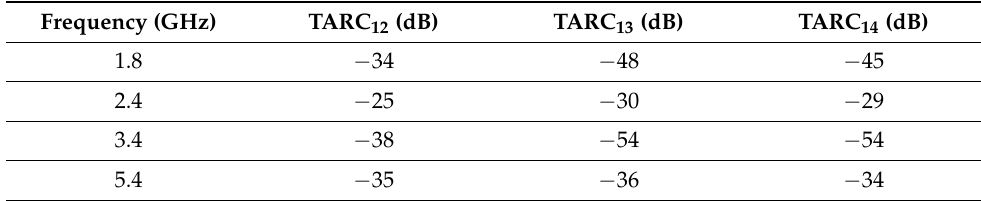
Table 3. Measured TARC of the proposed DS MIMO